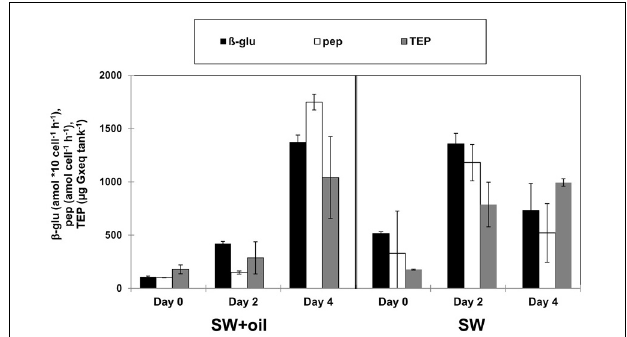
FIGURE 5 | TEP and enzymatic activities in GOE. Enzymatic activities of β -glucosidase ( β -glu) and peptidase (pep) show the same temporal patterns than TEP (transparent exopolymeric particles) in the tank with GCS-oil (SW + GCS-oil) and in the unamended tank (SW). Error bars indicate standard deviations of n =